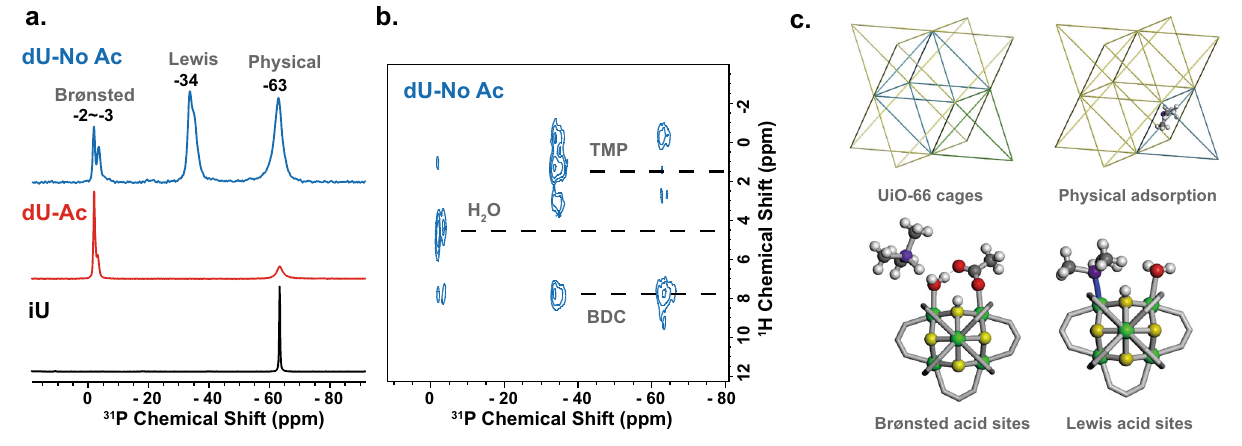
Fig. 2 | Adsorption of TMP. a 1 H- 31 P cross-polarization (CP) spectra of TMP adsorbed indU-NoAc(defectiveUiO-66withoutacetate),dU-Ac(defectiveUiO-66 with acetate) and iU(ideal UiO-66). The CP contact time is 2ms. The signals for physical adsoption, Lewis acid sites, and Brønsted acid sites are